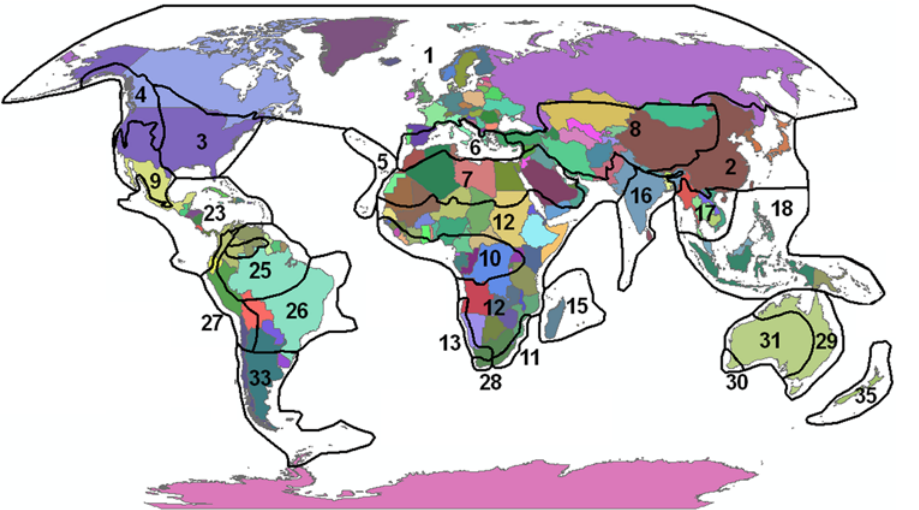
Figure 1. Floristic regions of the world, from Takhtajan [ 27 ] . Region names and associated statistics are listed in Tables 2 and 3. Those shown here do not include several largely oceanic or archipelagic regions ignored in the present analysis.